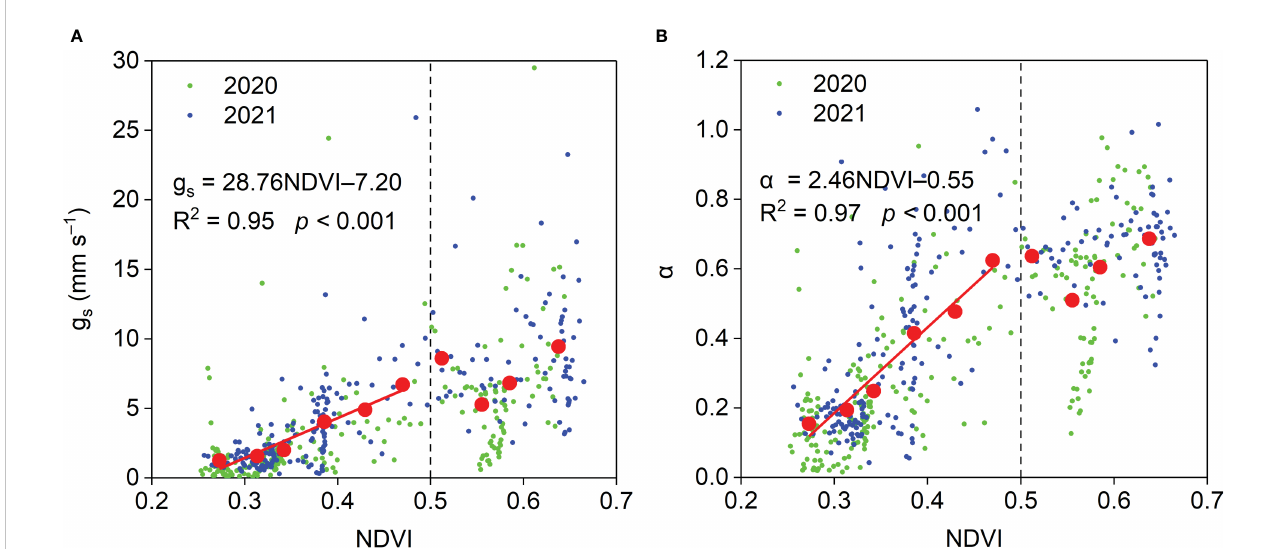
FIGURE 13 Relationships between midday (A) g s and (B) a and NDVI and during the growing season in the Pinus tabuliformis plantation. Red solid dots: the dependent variables were bin-averaged into 0.04 NDVI